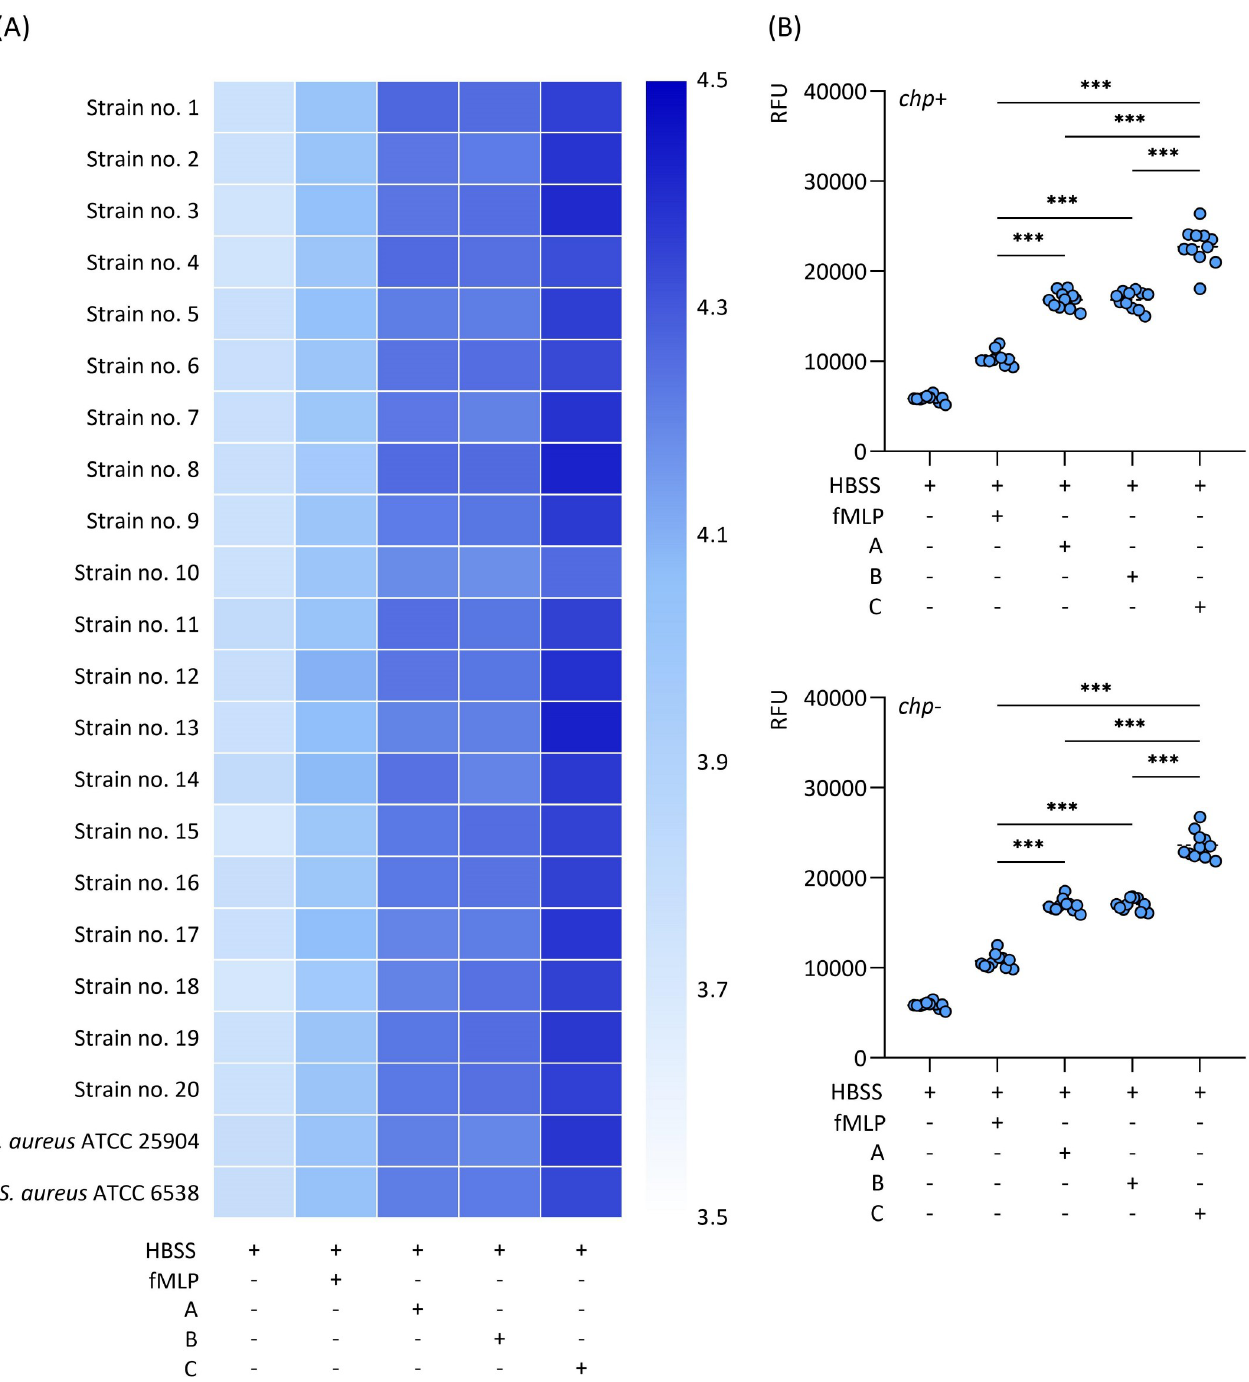
Fig 2. The differentiated HL-60 neutrophil-like cells chemotactic response to trans- anethole-treated Staphylococcus aureus strains. The heatmap (A) represents a log-mean relative fluorescence units (RFU) (+4.5 dark blue to 3.5 light blue). Scatter plots (B) demonstrating the distribution of mean RFU level for chp -positive ( chp +) and chp -negative ( chp -) S . aureus strains. A–Mueller-Hinton agar non-supplemented (MHA, control), B–MHA supplemented with 1% (v/ v) Tween 80, and C–MHA supplemented with 1% (v/v) Tween 80 and subinhibitory concentration of trans -anethole. Control–N-formyl-L-methionyl-L-leucyl- phenylalanine (fMLP, 100 μ mol/l), HBSS–Hank’s Balanced Salt Solution. *** P < 0.001.